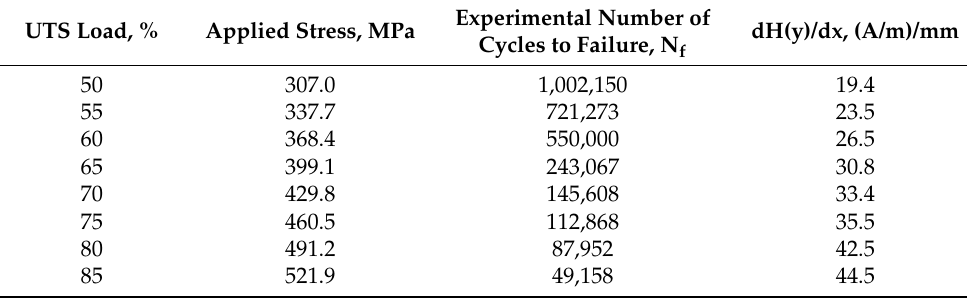
Table 4. Characterisation of magnetic flux leakage behaviour during uniaxial fatigue